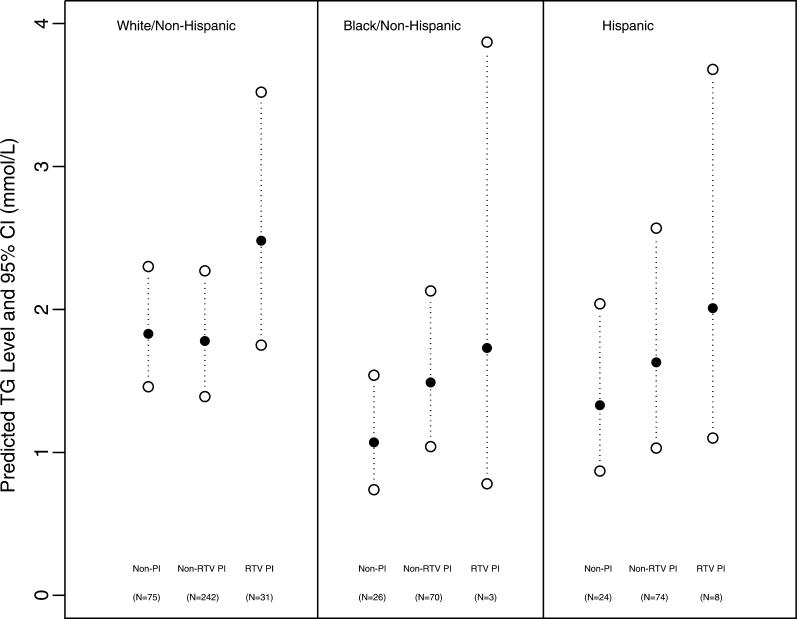
Predicted TG Levels for PI- and Non-PI–Exposed Individuals by Race/EthnicityEstimated fold increases (95% CI) for non-RTV–containing PI regimen (compared to no current PI exposure) are 0.97 (0.80, 1.18) for White/non-Hispanics, 1.39§ (1.02, 1.89) for Black/non-Hispanics, and 1.23 (0.89, 1.69) for Hispanics. Estimated fold increases (95% CI) for RTV-containing PI regimen (compared to no current PI exposure) are 1.35§ (1.00, 1.83) for White/non-Hispanics, 1.62 (0.75, 3.50) for Black/non-Hispanics, and 1.51 (0.91, 2.52) for Hispanics. § Indicates significantly different than 1.0-fold at the 0.05 level.